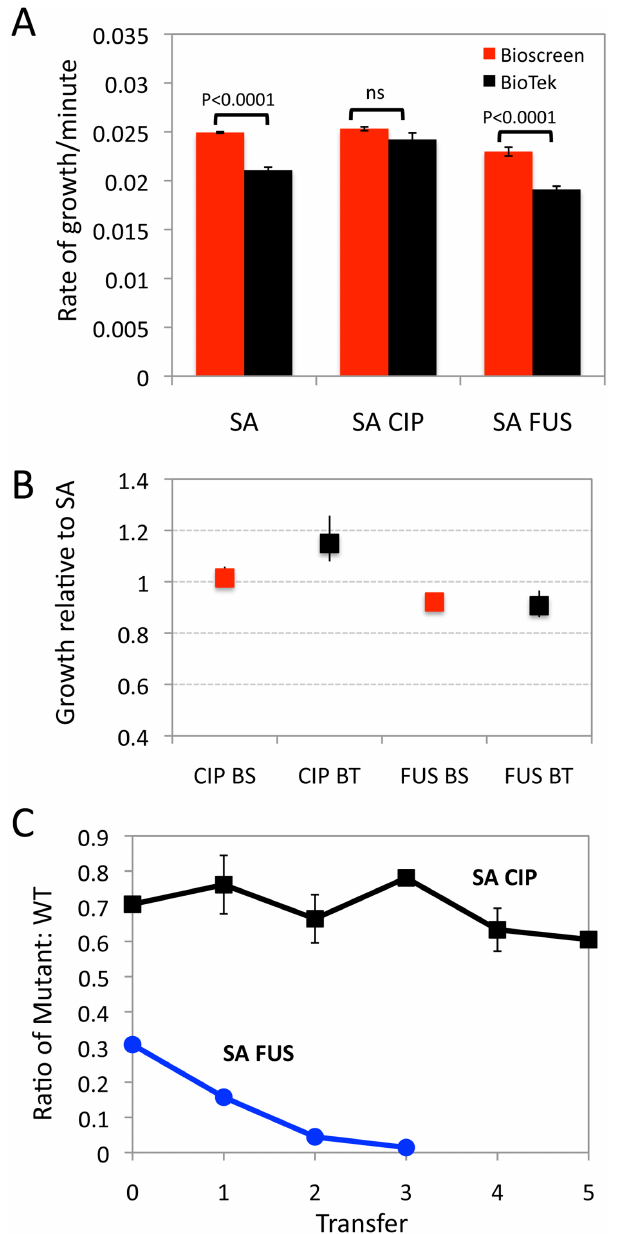
Fig 3. Malthusian parameter and pairwise competition estimates of fitness for S . aureus ciprofloxacin and fusidic acid susceptible and resistant mutants (A) Growth rates estimates from three S . aureus strains using a Bioscreen (BS, red bar) and BioTek (BT, black bar) plate readers. SA is an antibiotic sensitive strain, SA-CIP is a ciprofloxacin resistant strain and SA-FUS is a fusidic acid resistant strain. (B) Malthusian parameters relative to wild type (SA), (Bioscreen red BioTek black) and Bootstrap-calculated confidence intervals. (C) Changes in the ratio of the antibiotic resistant mutants and SA WT in pairwise competition SA-CIP (black) and SA-FUS (blue), mean and standard deviation of the ratios from three independent competition experiments.